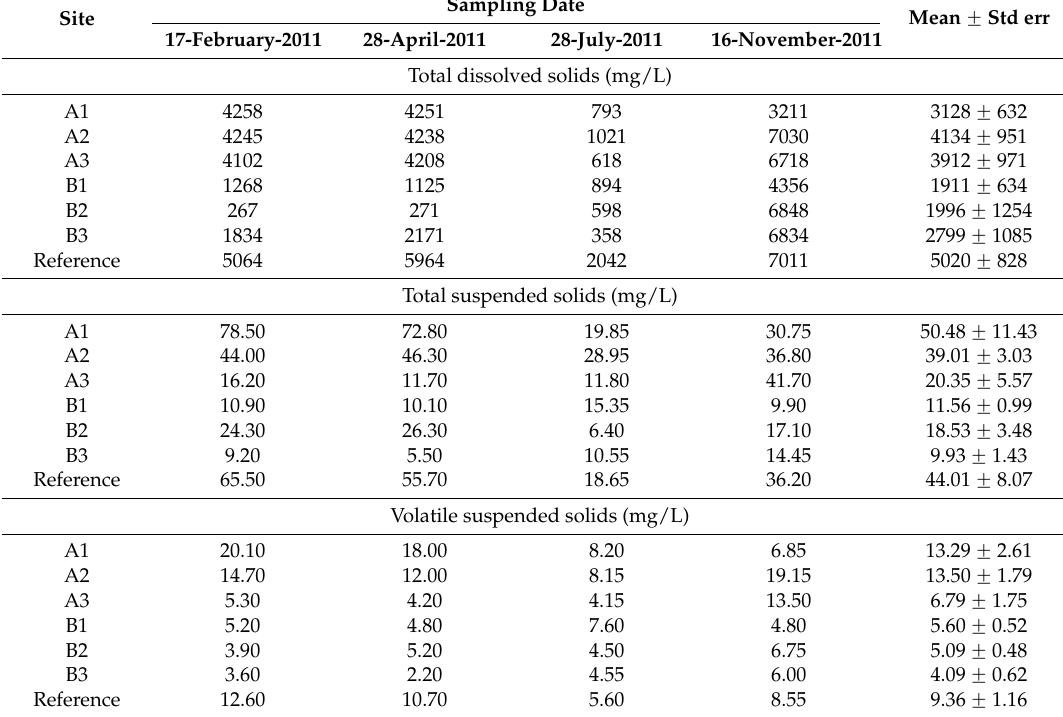
Table 3. Surface water total dissolved solids, total suspended solids, and volatile suspended solids measured at sampling sites in the